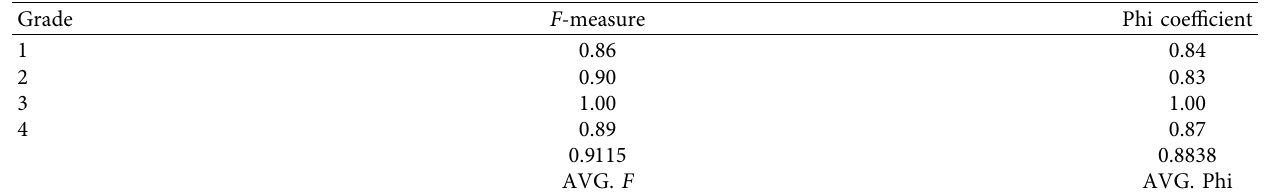
Table 11: Performance evaluation results of the fusion